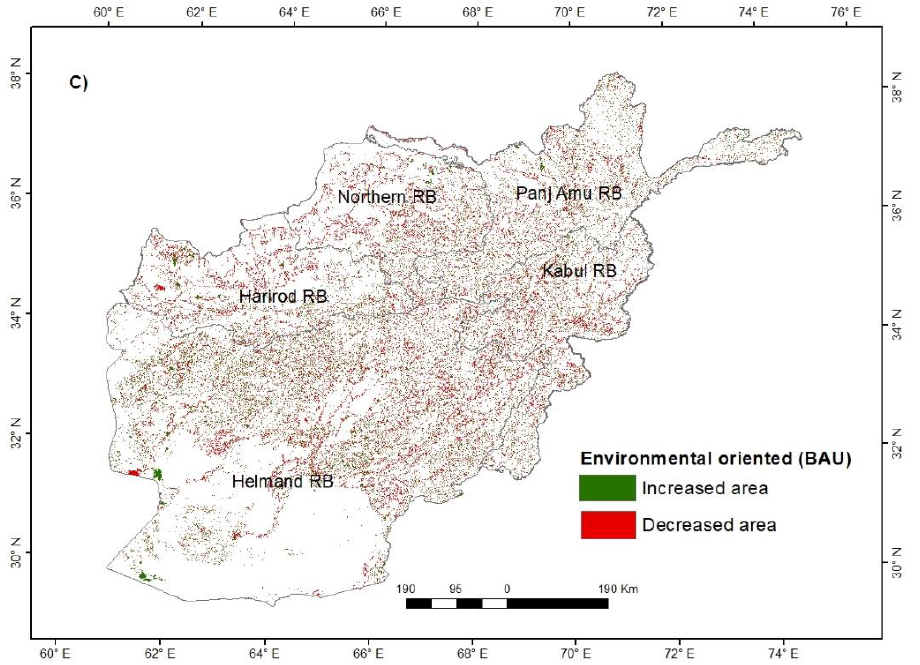
Figure 8. Spatial distribution of the predicted LULC in 2030 under the BAU scenario; ( A ) overall simulated LULC; ( B ) Simulated changes in economic-oriented LULC classes; ( C ) Simulated changes in environmental-oriented LULC classes.